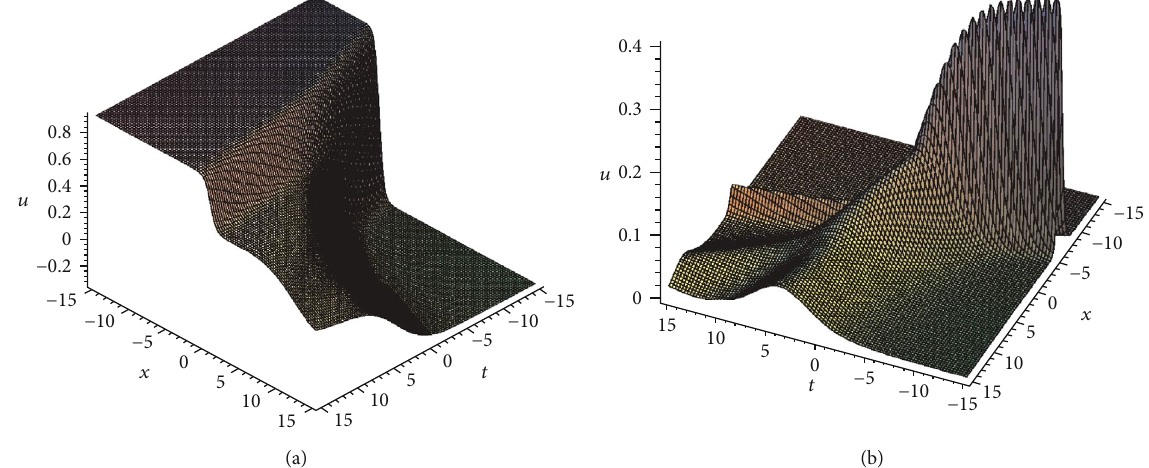
Figure 4: Plot (a) and (b) to the resonant soliton solution of u and v . (a) is a graph of u , which shows that three kink solitary waves collide and fuse into a resonant soliton solution at t = 0 . (b) is a graph of v , which shows that three bell solitary waves collide and fuse into a resonant soliton solution at t = 0